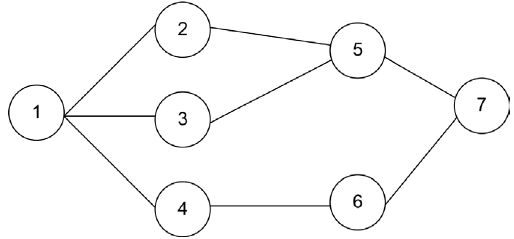
Fig. 8. The project network (Liu et al . 1995)